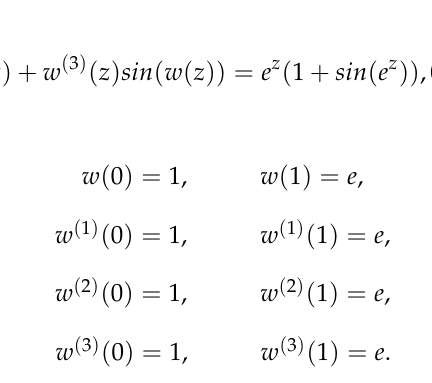
Table 11. Comparison of exact solution and presented method solution of Problem 4 at h = 1